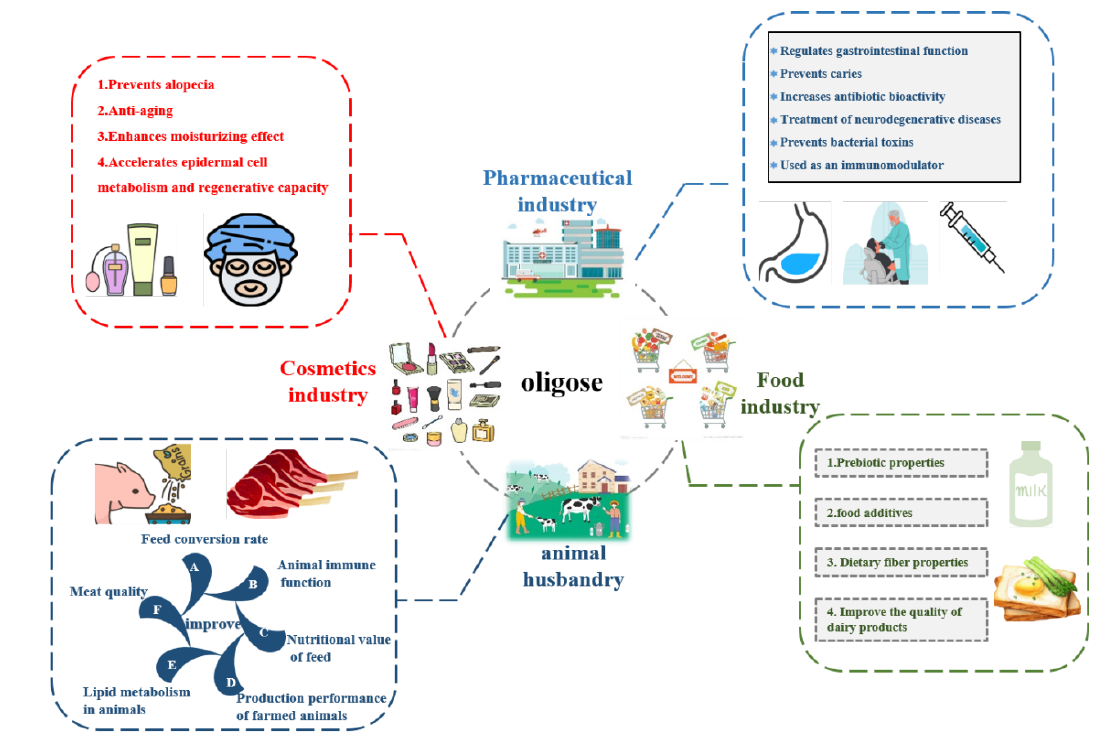
Figure 5. Related applications of oligosaccharides.